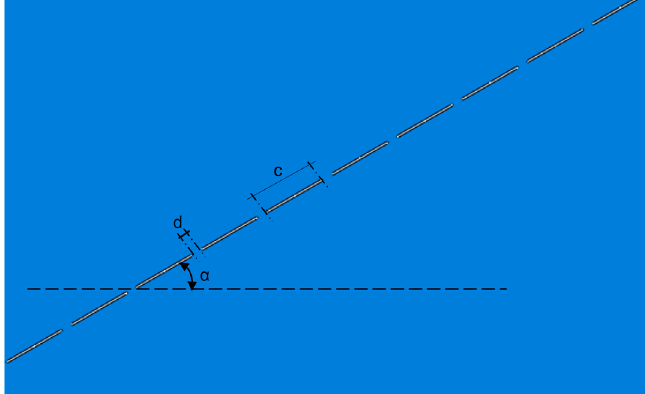
Figure 1 . Design parameters . Figure 1. Design